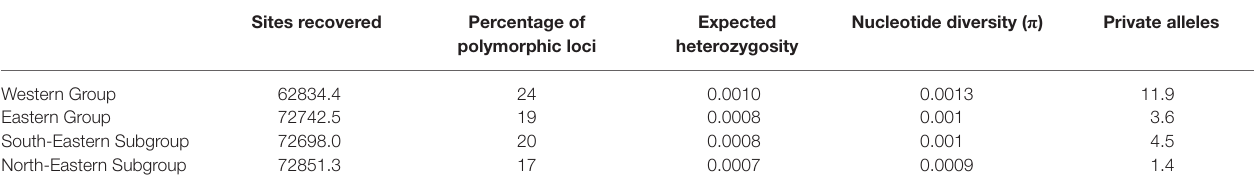
TABLE 1 | Descriptors of the population groups of Helleborus niger identified based on restriction-site associated DNA sequencing (RADseq) data